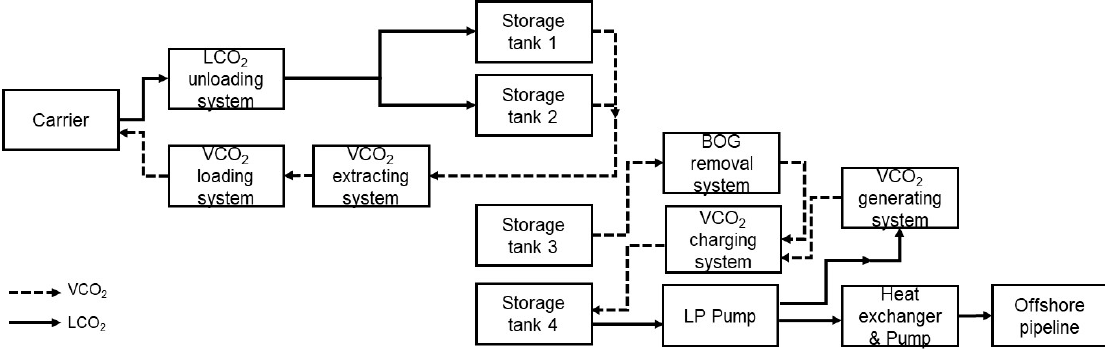
Figure 9. The extended process flow block diagram of the CO 2 terminal.